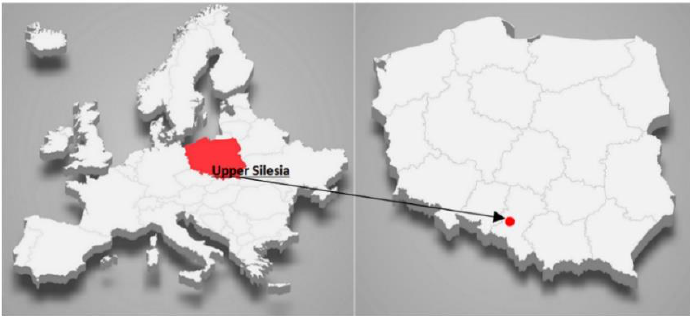
Figure 1. Localization of the measurement point in Gliwice, Upper Silesia, Southern Poland.